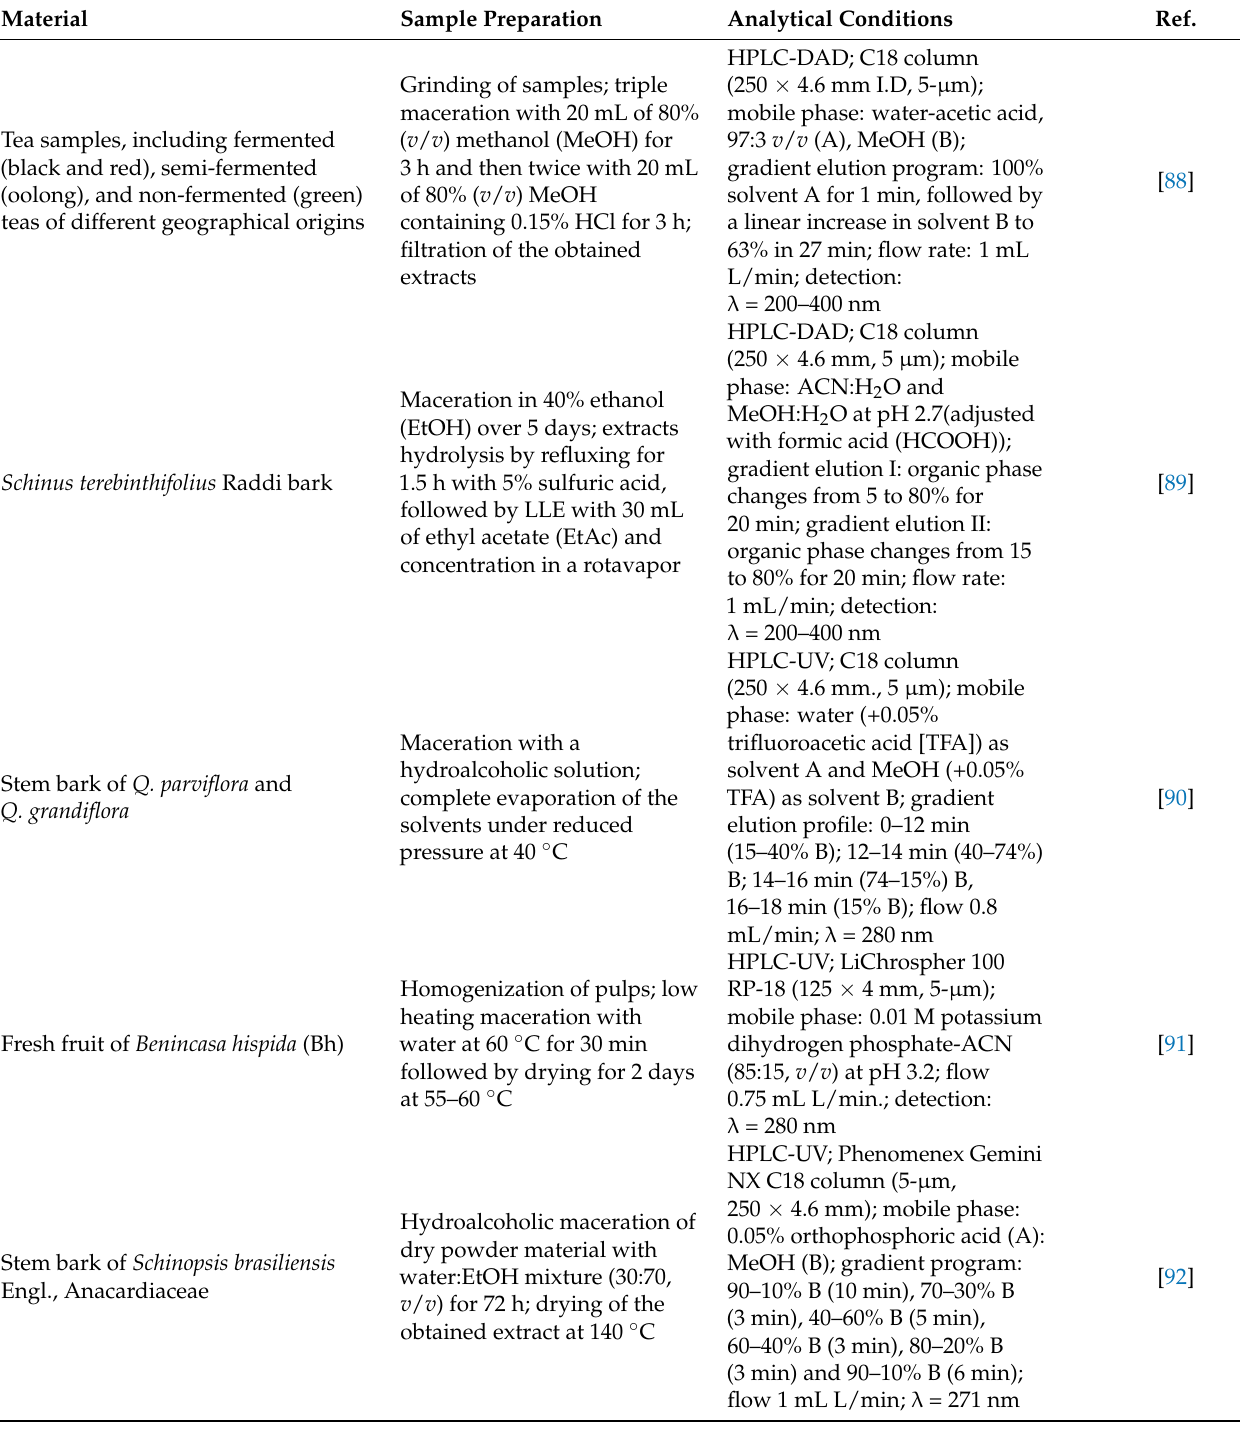
Table 3. The review of representative conditions for gallic acid isolation and analysis by HPLC, HPLTC, GC, and electrochemical methods in various solid and liquid matrix